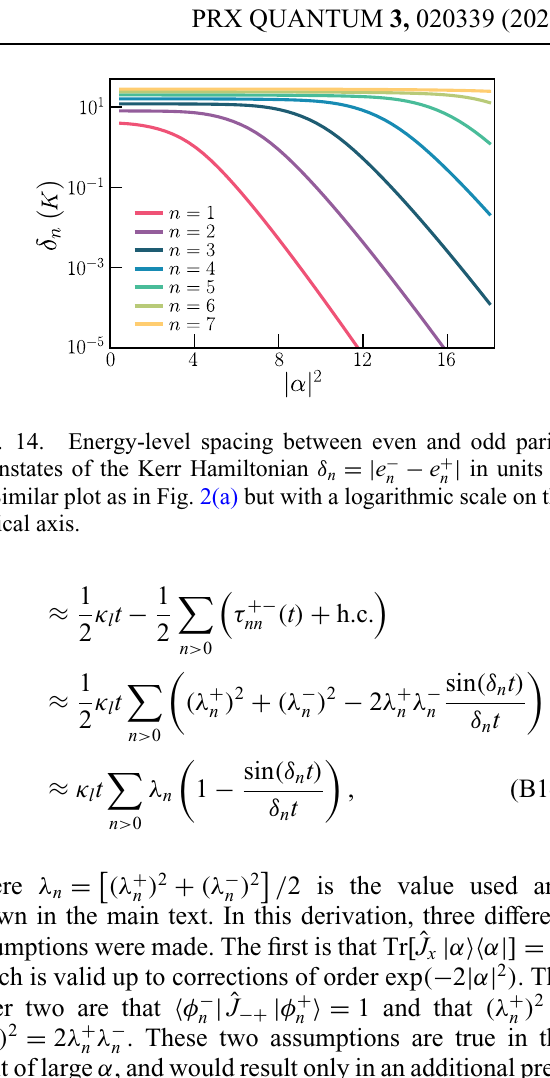
other two are that (cid:9) φ −